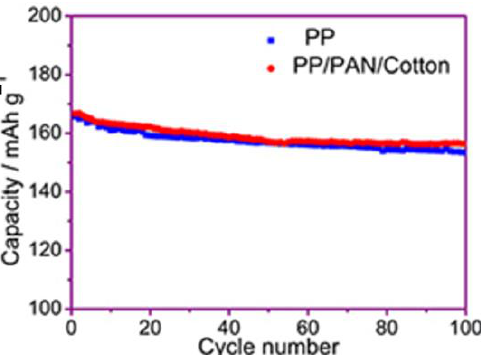
Figure 10. Cycle performance of the batteries by PP membrane and modified PP/PAN/cotton fibers composite membrane.